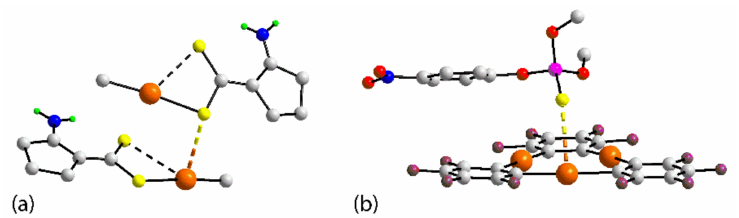
Figure 2. Supramolecular association in zero-dimensional aggregates featuring a single Hg ··· S interaction: ( a ) 1 and ( b ) 2 . The black dashed lines in ( a ) represent intramolecular Hg ··· S contacts (3.080(2) and 3.163(3) Å). Additional colour code: pink—phosphorus; blue—nitrogen.